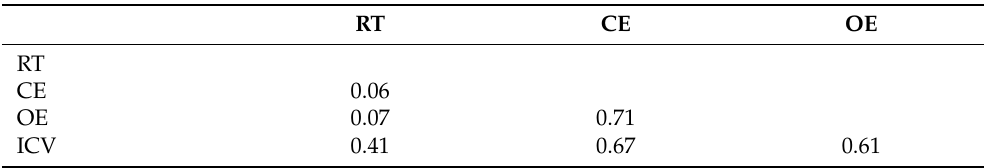
Table A2. Correlations between behavioral cognitive test results in both groups and sessions ( n = 48). Values in red denote significant correlations at p <